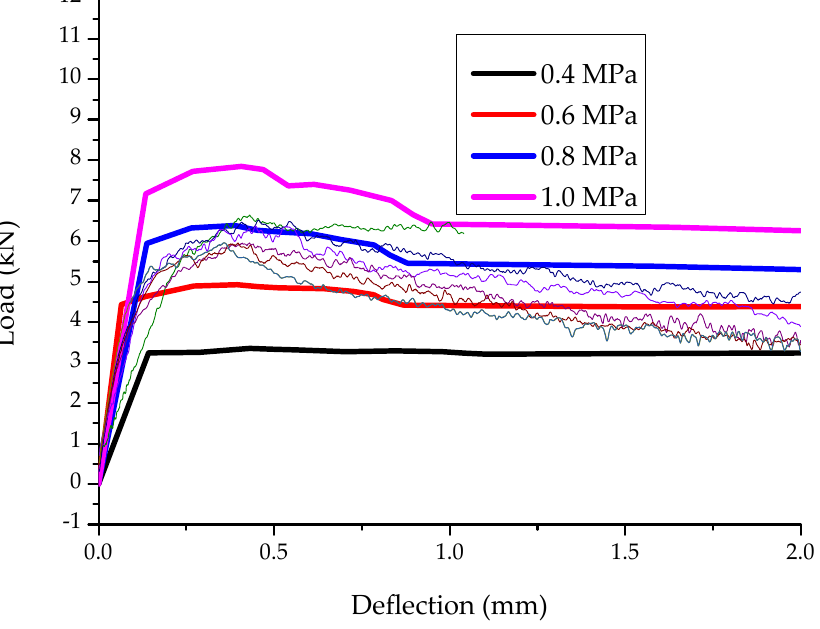
Figure 14. Experimental vs. numerical results of the examined prisms .